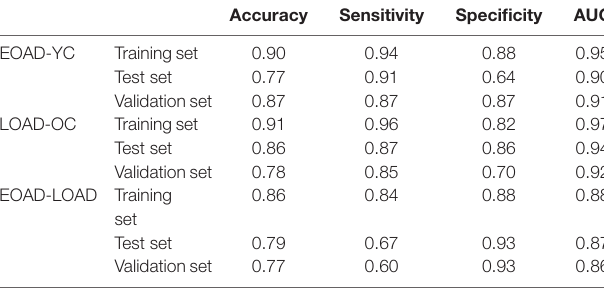
TABLE 3 | Classification performance on test and validation